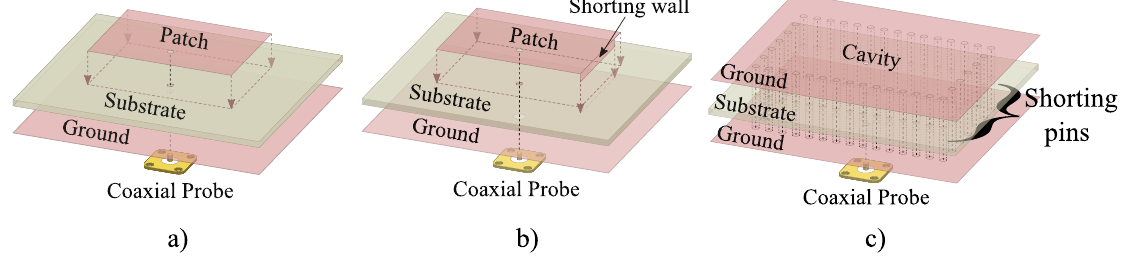
Figure 3. ( a ) Microstrip antenna. ( b ) Planar inverted F-antenna (PIFA). ( c ) Substrate integrated waveguide (SIW)